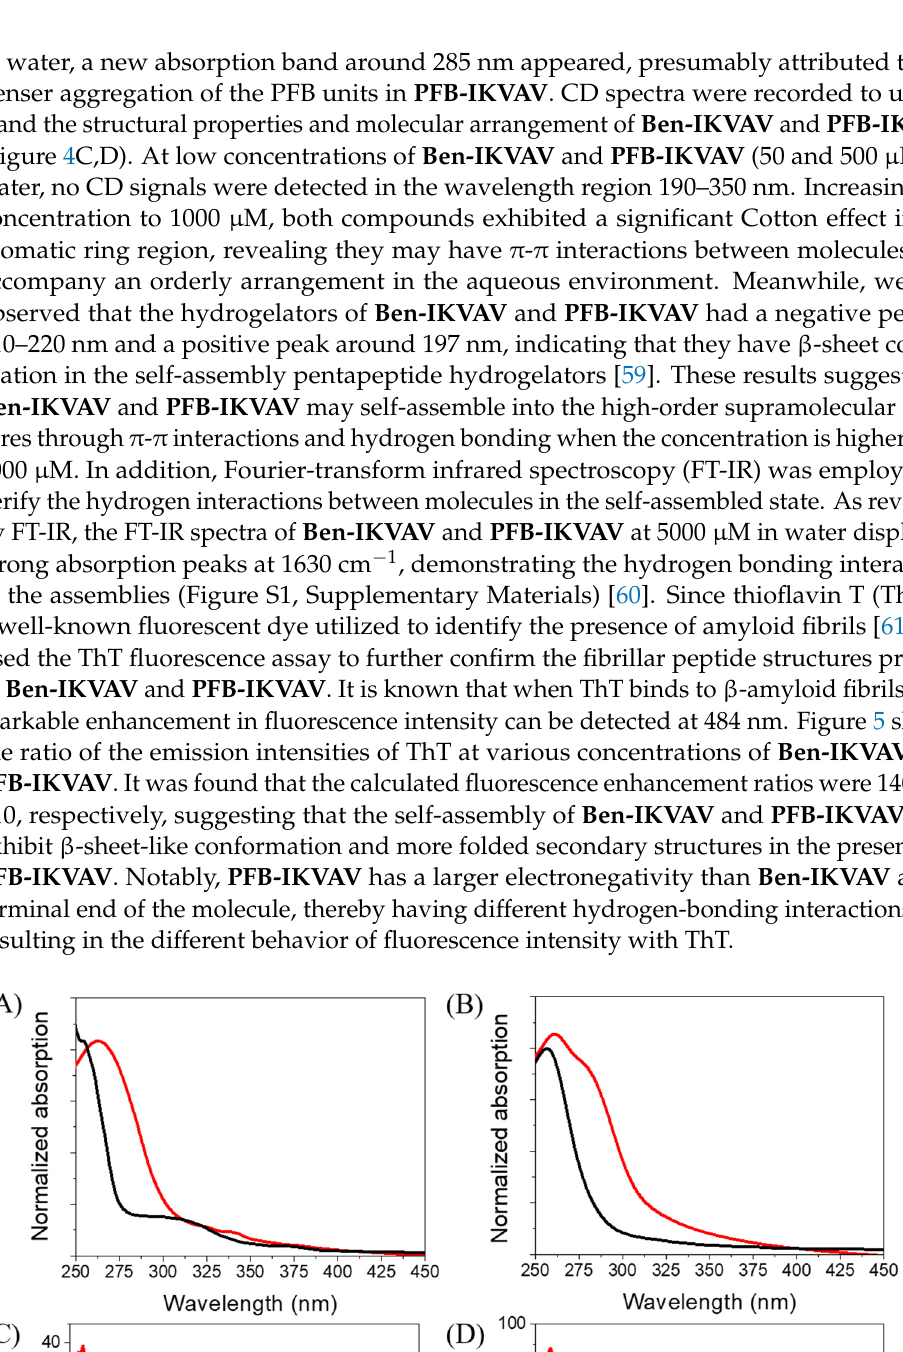
Figure 5. Emission intensities of ThT at various concentrations of hydrogelators of ( A ) Ben-IKVAV and ( B ) PFB-IKVAV . (I 0 : without adding hydrogelators.). 2.4. Cytotoxicity Test To evaluate the potential biological applications of Ben-IKVAV and PFB-IKVAV , we performed a biocompatibility test of these hydrogelators against hMSCs through MTT [3-(4,5-dimethylthiazol-2-yl)-2,5-diphenyltetrazolium bromide] assay [62], and the results are presented in Figure 6. The concentrations of Ben-IKVAV and PFB-IKVAV were se- lected in the range of 10–500 μ M, and the cell viability measurements were processed at 24 and 48 h after cell seeding. We found that the half-inhibitory concentration (IC 50 ) of the two compounds was greater than 500 μ M, and the cell viabilities were over 75% when cultured at a concentration of 500 μ M for 48 h. Therefore, it can be proved that the two compounds have good biocompatibility and can be further used for cell differentiation studies.